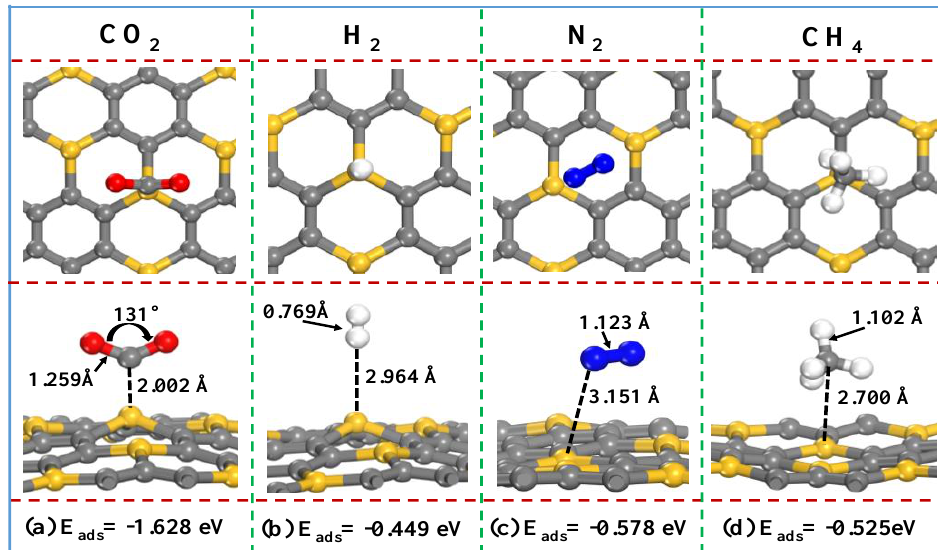
Figure 3. Top and side views of the stable adsorption configurations of different gas molecules adsorbed on SiC 3 nanosheet after the injection of the negative charges with density of 1.23 × 10 14 e − /cm 2 . ( a ) CO 2 , ( b ) H 2 , ( c ) N 2 , and ( d ) CH 4 adsorbed on the SiC 3 .